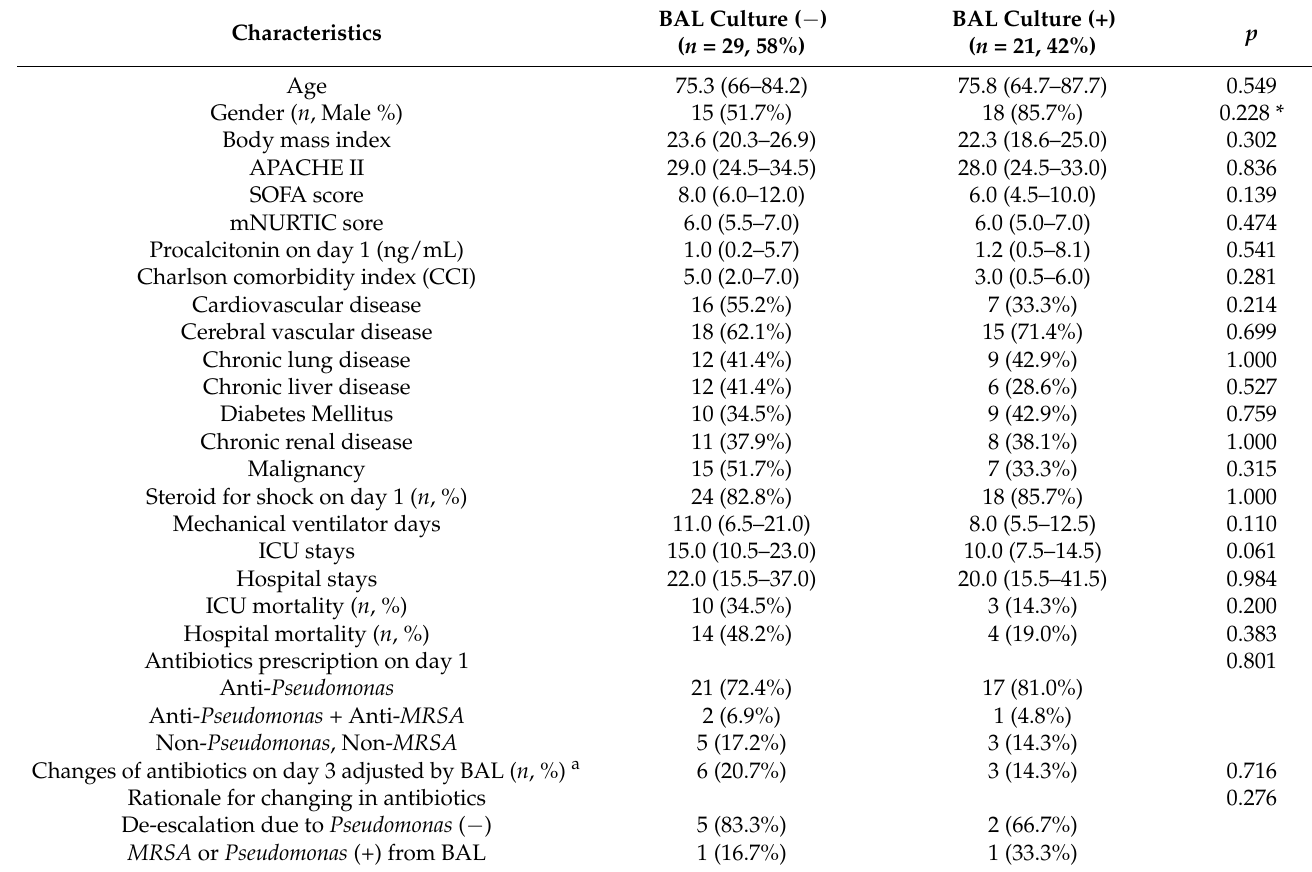
Table 2. Patient demographic characteristics, severity index, comorbidities, and antibiotic prescription pattern according to the BAL culture results ( n =